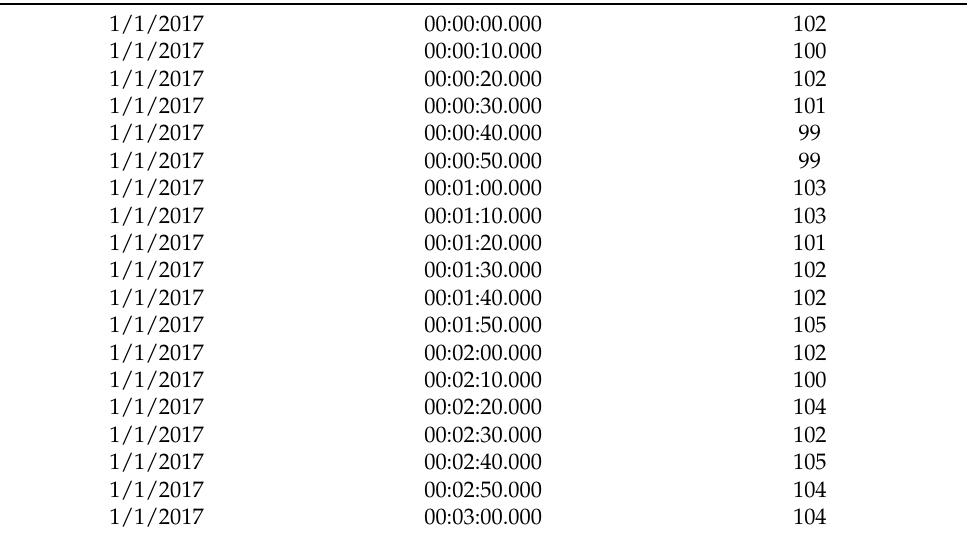
Table A1. Data file. Name of file: 1012017.csv (month/day/year). File content: day/month/year,